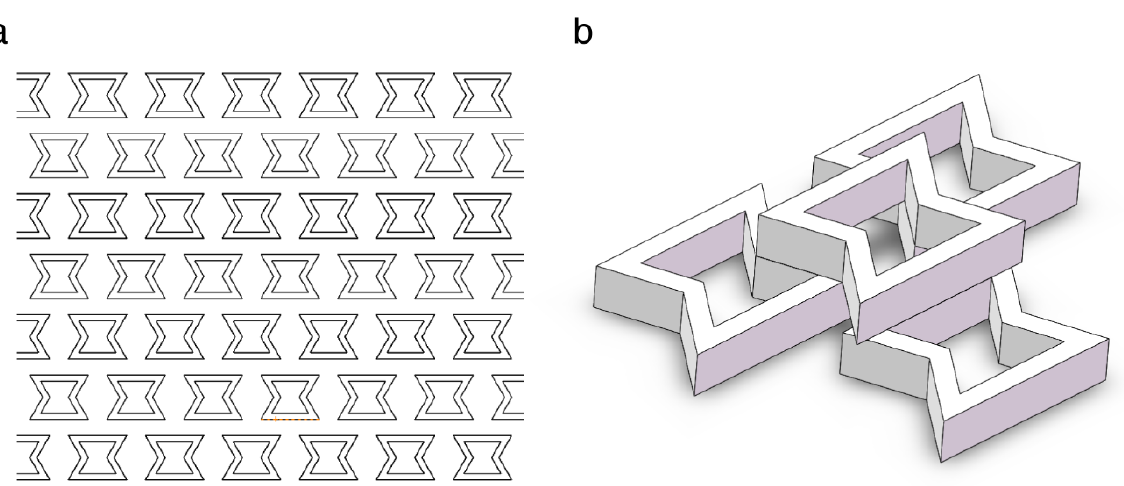
Figure 1. Layer of concave hexagons ( a ) and a stack of concave hexagons ( b ). In order to evaluate the porosity and mechanical properties of the scaffolds printed through different filled patterns, a 3D model (20 mm × 20 mm × 1 mm) was created using Solidworks 2018 software. For this material, we designed a study using the common orthogonal, triangular, and designed concave hexagon filled patterns. The models of the three different filled patterns are shown in Figure